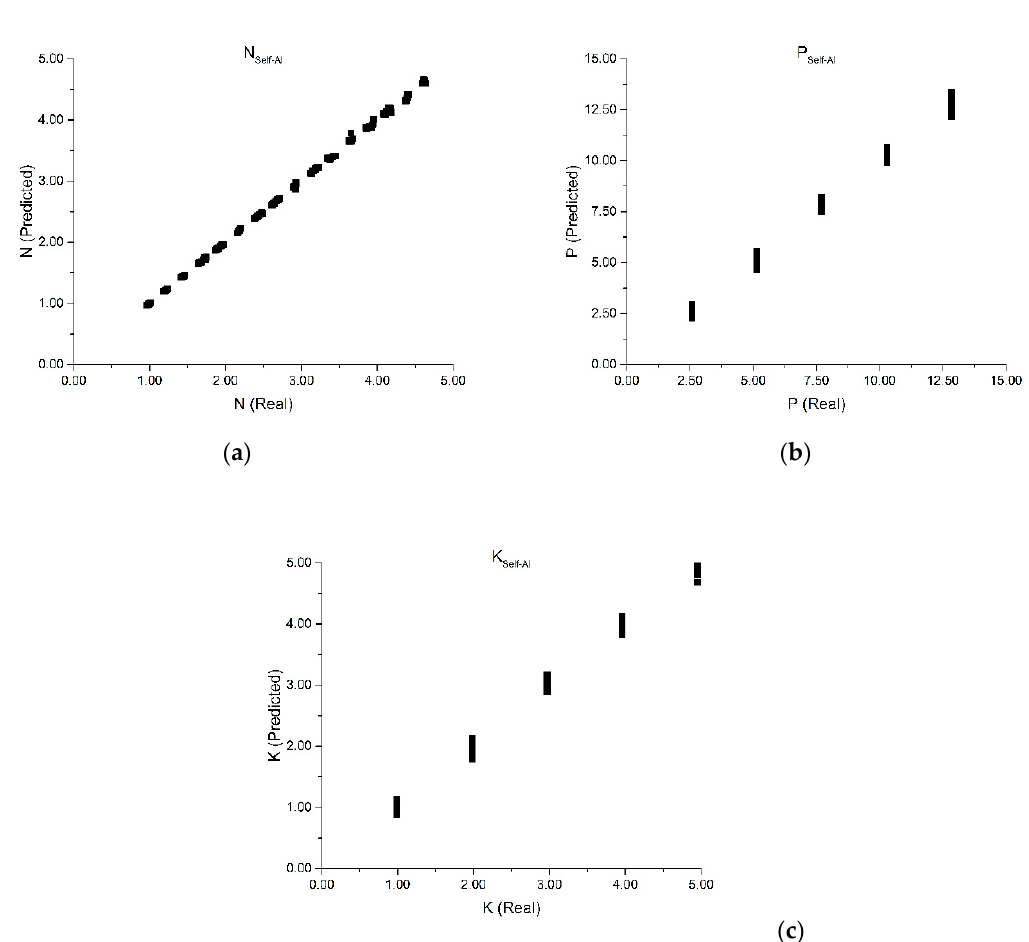
Figure S1: Test A1 and A2, Figure S2: Test B1 and B2, Figure S3: Test C1 and C2, Figure S4: Test D1 and D2, Figure S5: Acquired spectra for Tests A1 and Test A2, Figure S6: Acquired spectra for Tests B1 and Test B2, Figure S7: Acquired spectra for Tests C1 and Test C2, Figure S8: Acquired spectra for Tests D1 and Test D2, Table S1: Irrigation tanks discrimination per fertilizer and supplier brand, Table S2: Calibration values obtained from data, with linear and logarithmic correlations, Table S3: Crossed interference matrix excerpt, with values of each ionic species, on two